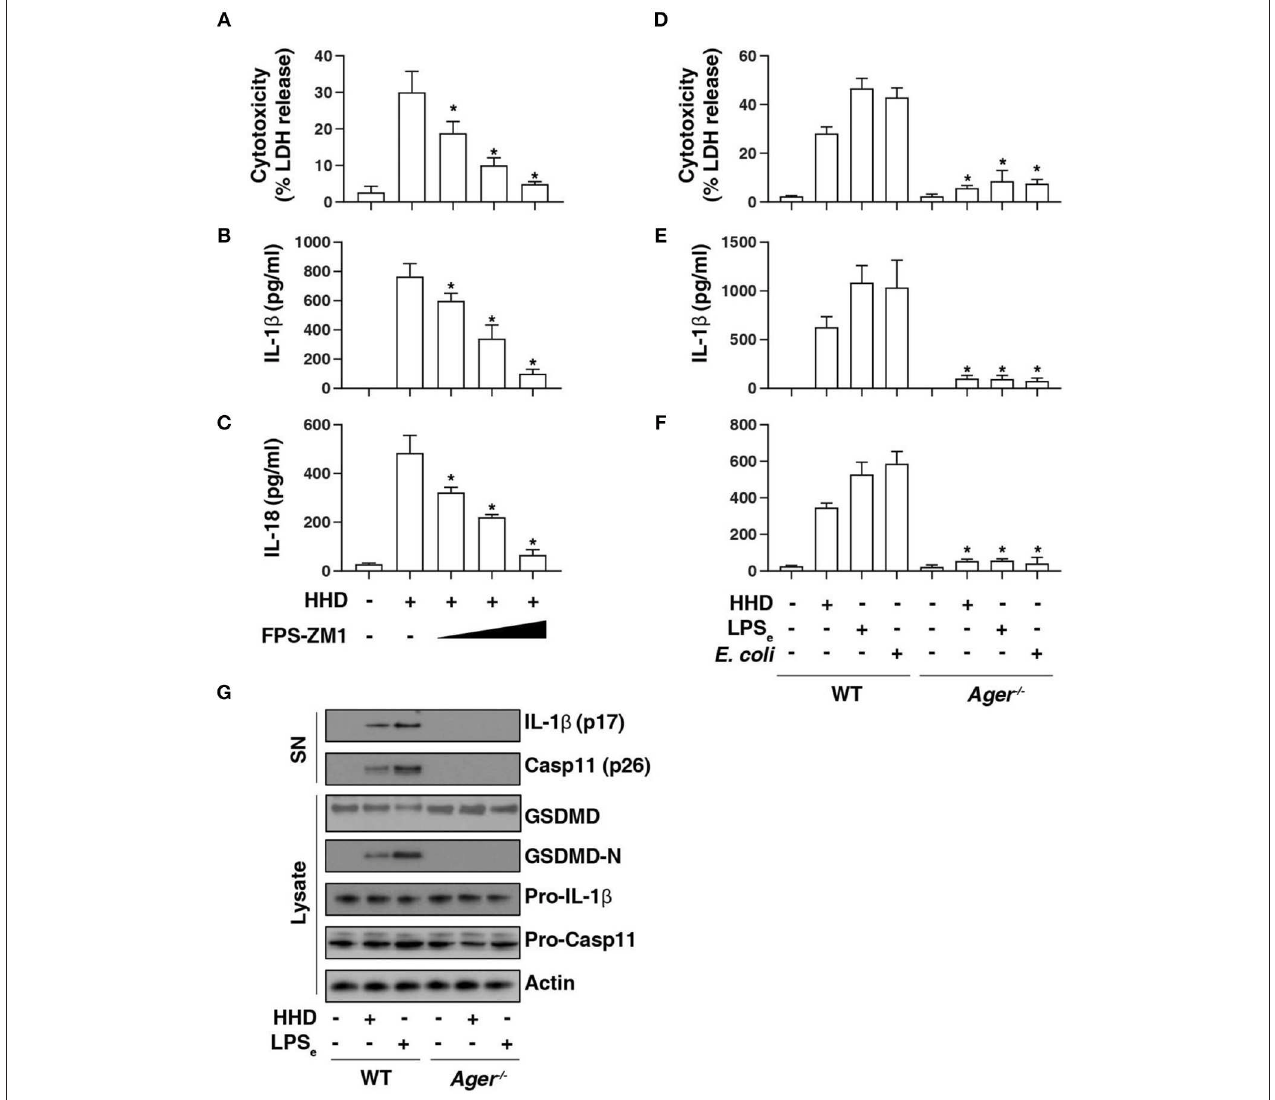
FIGURE 3 | AGER is required for caspase-11 inflammasome activation. (A–C) Analysis of cytotoxicity (A) , IL-1 β release (B) , and IL-18 release (C) in LPS-primed BMDMs after HHD treatment (500ng/ml, 16h) in the absence or presence of FPS-ZM1 (100nM, 500nM, and 1 µ M). n = 3, data expressed as means ± SD of three independent experiments, * P < 0.05 vs. HHD group, t test. (D–F) Analysis of cytotoxicity (D) , IL-1 β release (E) , and IL-18 release (F) in indicated LPS-primed BMDMs after HHD treatment (500ng/ml, 16h), LPS electroporation (LPS e ; 1 µ g, 16h), or E. coli infection (MOI = 25, 16h). n = 3, data expressed as means ± SD of three independent experiments, * P < 0.05 vs. WT group, t test. (G) Western blot analysis of indicated proteins in the supernatant (SN) or cell lysate in LPS-primed BMDMs after HHD treatment (500ng/ml, 16h) or LPS electroporation (LPS e ; 1 µ g, 16h). Western blot data represent two independent